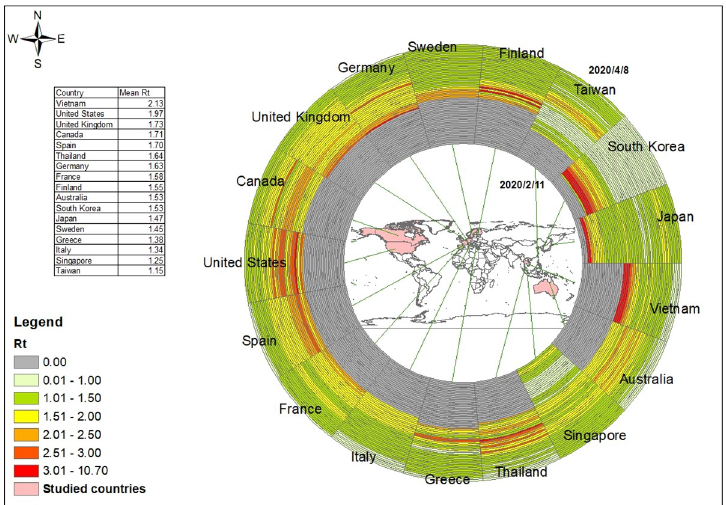
Fig 2. Ring map of daily effective reproduction number (Rt) with 7-day window of COVID-19, Feb. 11 to Apr. 8, 2020.